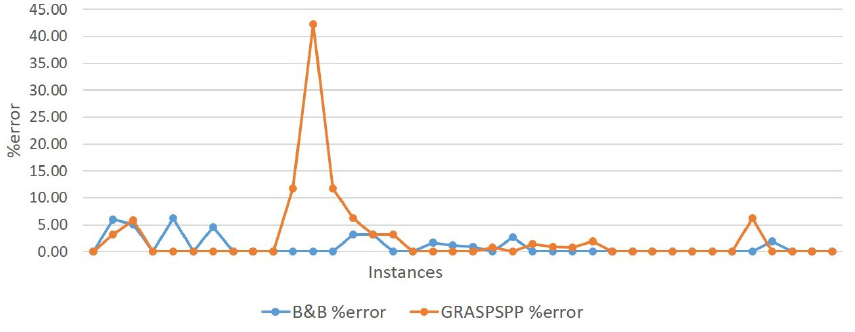
Figure 10. Percentage error (%error) results between GRASPSPP and B&B.